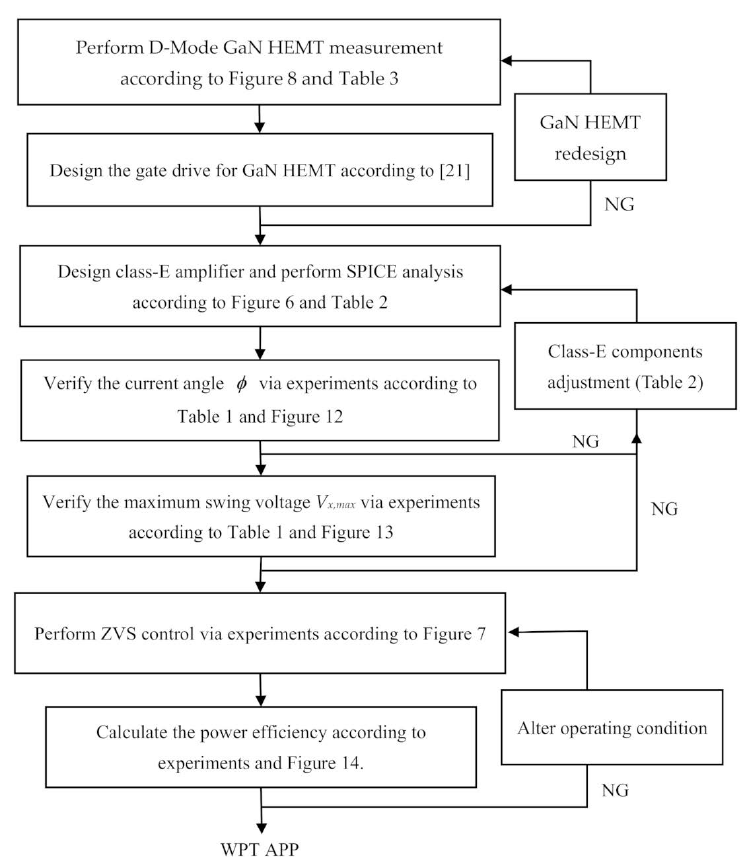
Figure 16. Flowchart of a systematic procedure for WPT